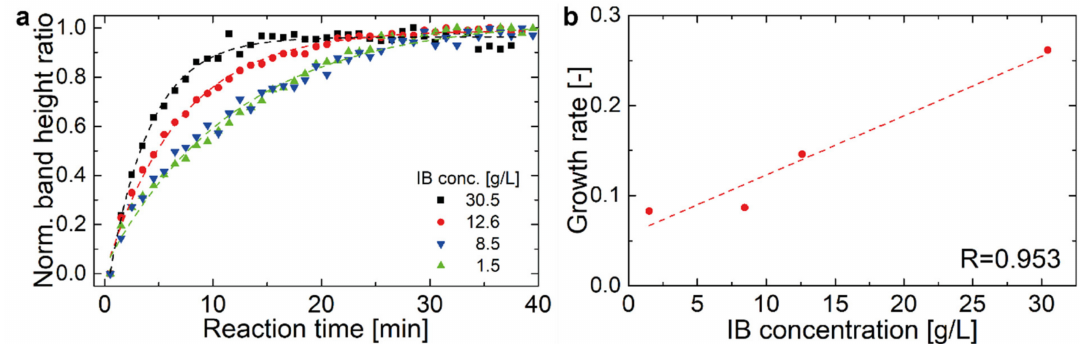
Figure 4. ( a ) Progression of the normalized band ratio with time of four investigated IB concentrations. ( b ) Growth rate vs IB concentration shows linear